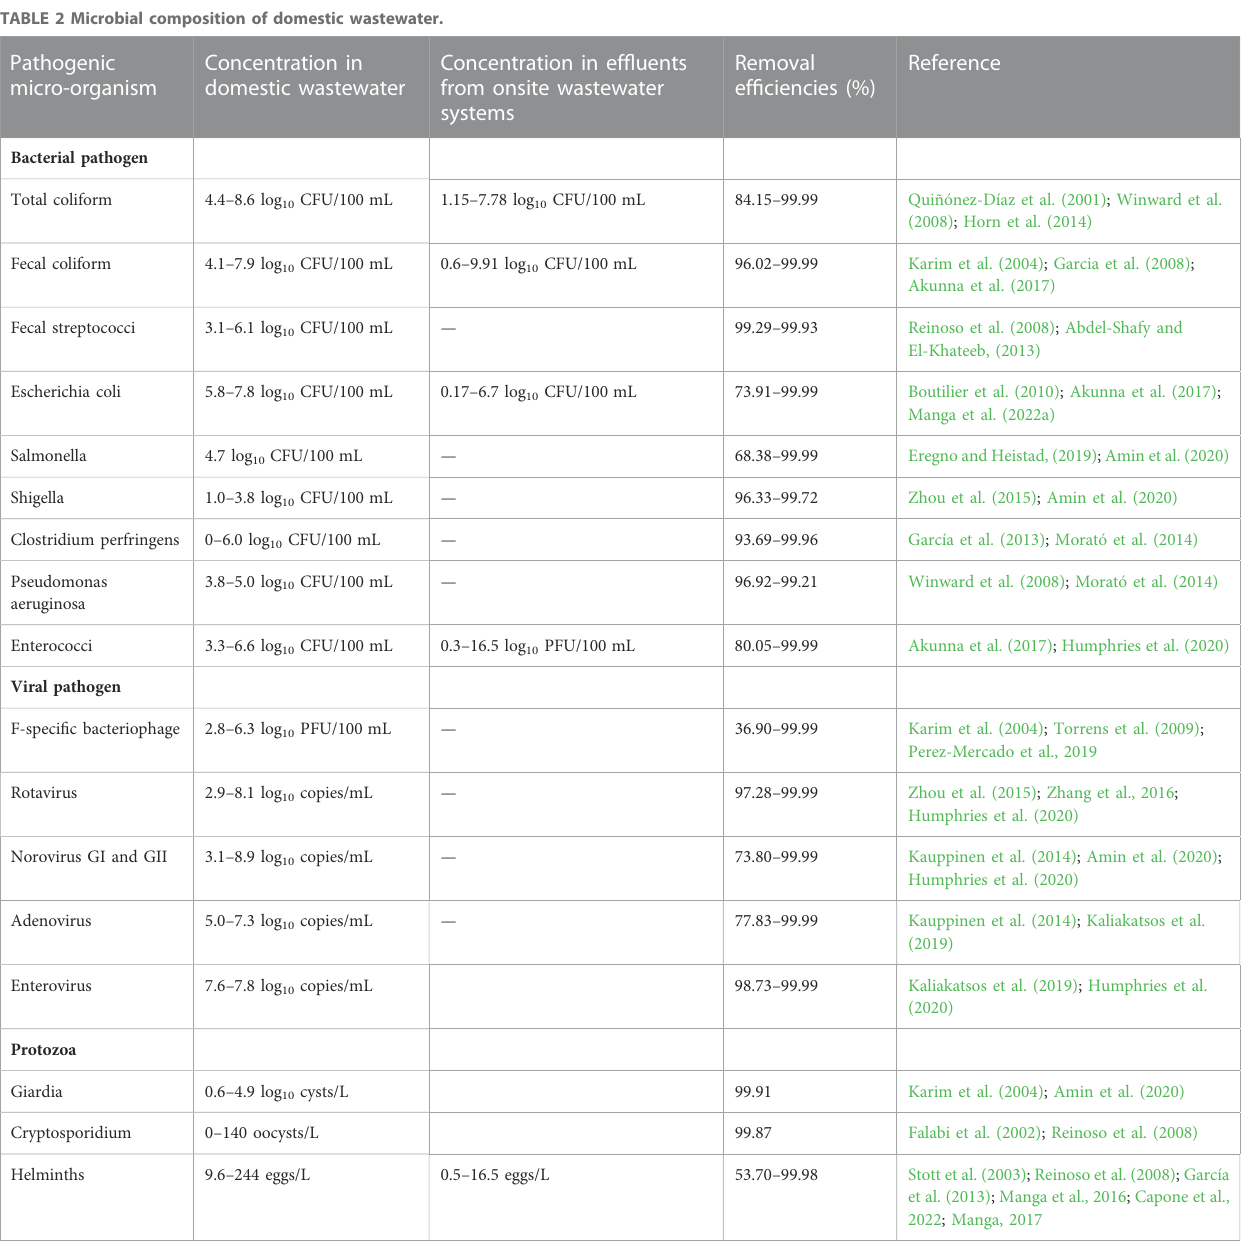
TABLE 2 Microbial composition of domestic